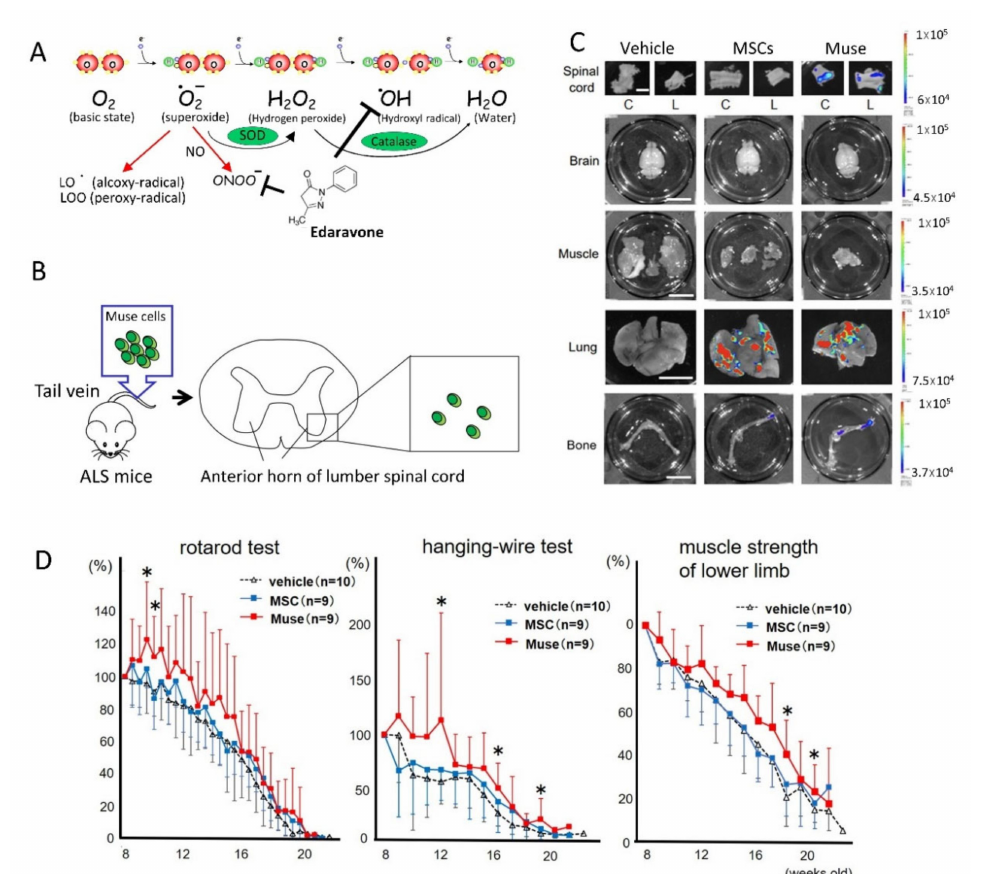
Figure 8. Effectiveness of human Muse cells in a mouse ALS model. ( A ) Free radicals and mechanism of action of a free radical scavenger, edaravone. Free radicals, such as hydroxyl radicals ( • OH), are produced under pathologic conditions. Hydroxyl radicals are extremely reactive among reactive oxygen species and oxidize biologic components, such as proteins, lipids, sugars, and nucleic acids, causing neuronal cell death. On the other hand, edaravone is thought to mainly detoxify hydroxyl radicals by donating electrons. ( B ) Schema of intravenous administration therapy with Muse cells for ALS mice. Muse cells administered by tail vein injection migrated to the lumbar spinal cord and survived for a long period of time. ( C ) In vivo dynamics of Nano-lantern-labeled MSCs and Muse cells. Only Muse cells and not MSCs homed to the cervical (C) and lumbar (L) spinal cord. Both MSCs and Muse cells were detected in the lung and the femur. ( D ) Clinical analysis of ALS mice treated with vehicle, MSC, and Muse cells (modified from Yamashita et al., 2020 [36]). Mice receiving Muse cells showed significant improvement in the rotarod test, hanging-wire test, and lower limb muscle strength (* p < 0.05 vs. vehicle). The figure is reproduced from Yamashita et al., Sci Rep, 2020